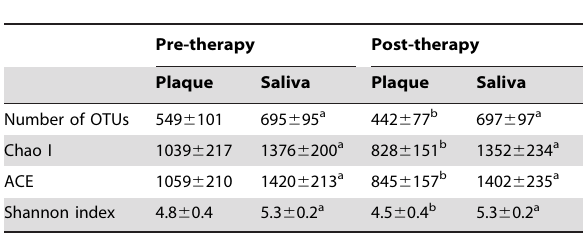
Table 3. Sequence diversity in each sample.